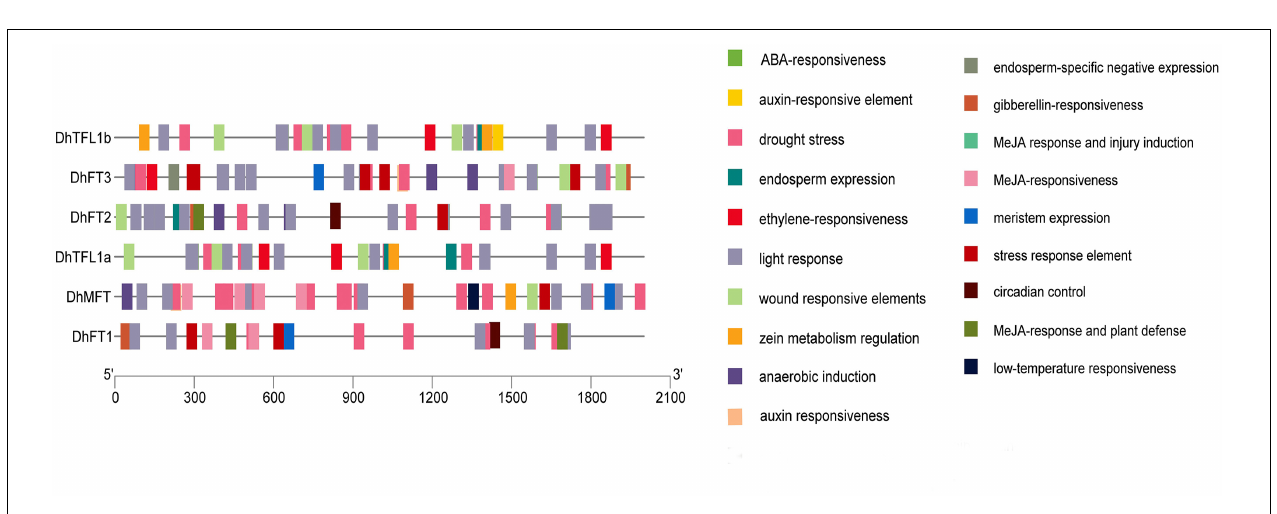
FIGURE 7 | The cis -acting element of